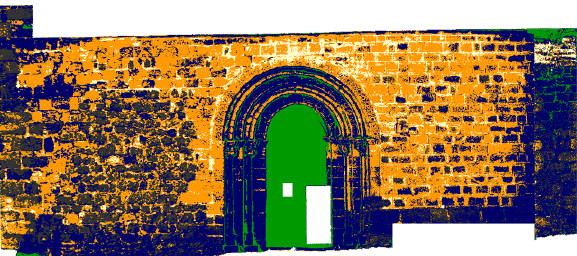
Figure 7. Nikon D5000 map for the 6-classes unsupervised classification.